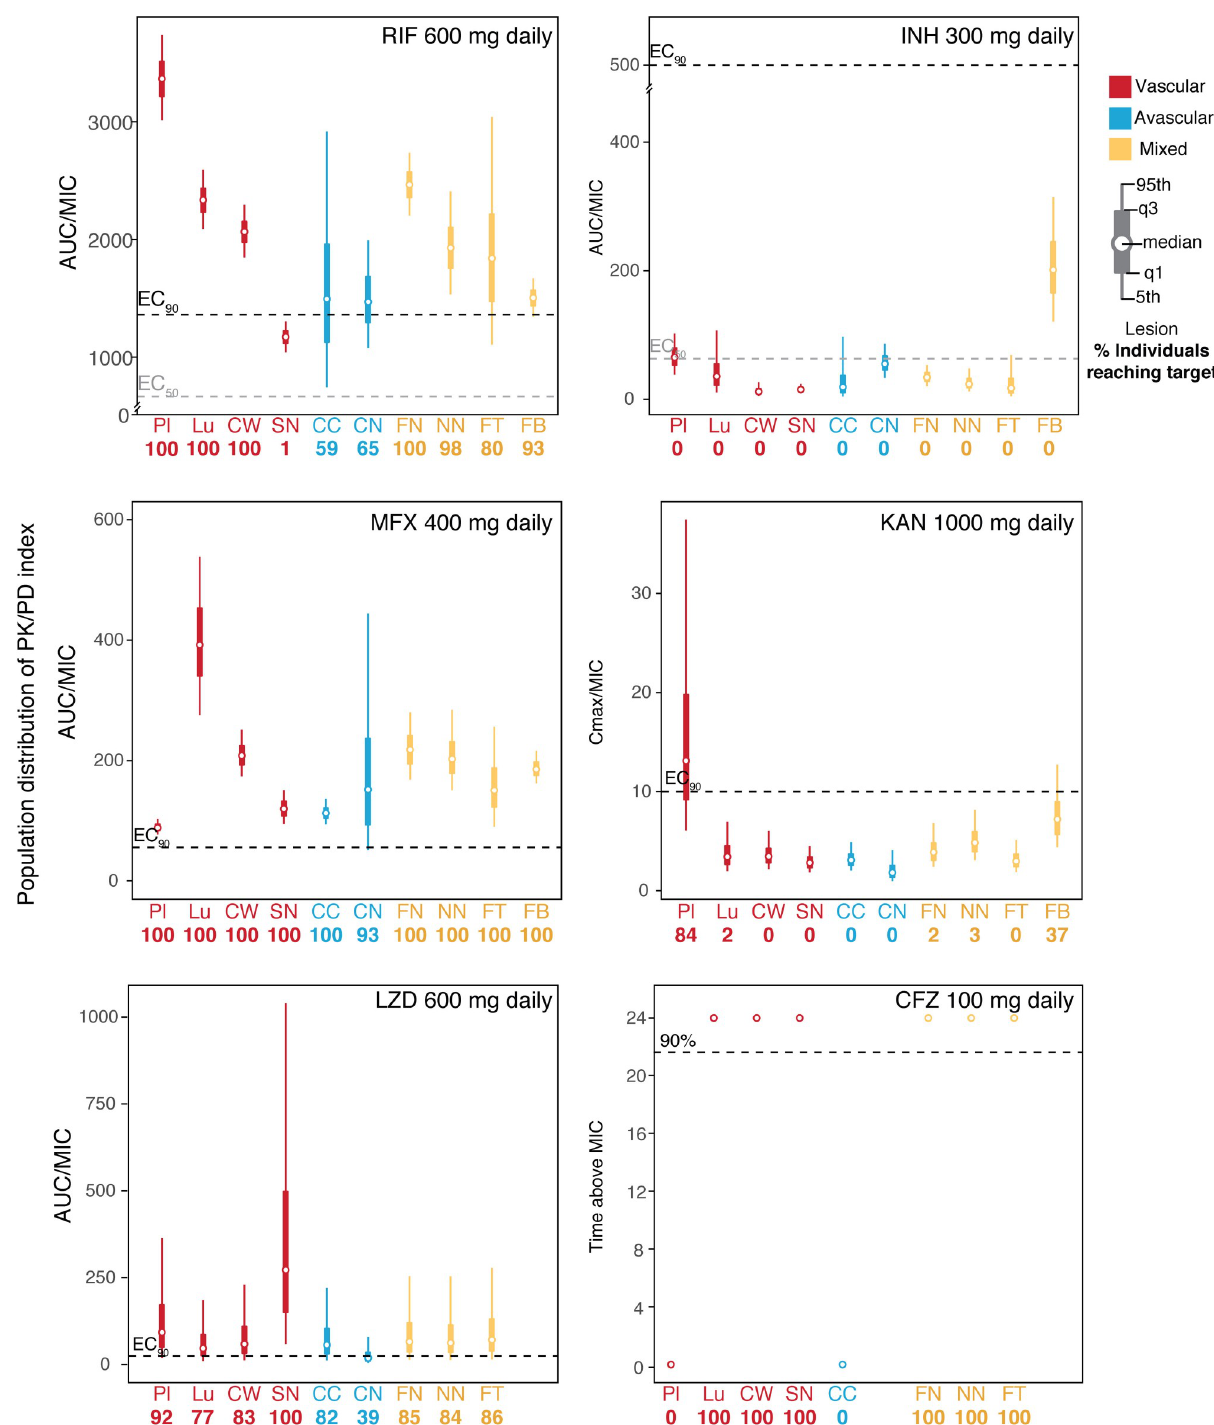
Fig 6. Distribution of PK/PD target attainment per drug. Exposure of 1,000 simulated patients are represented as box plots in each lesion to visualize the distributed PK/PD efficacy for individual drugs and lesions. Each panel represents an individual drug given at their standard dose until steady state is reached. The dashed lines indicate published target attainment PK/PD ratios, for which black dashed lines indicate the critical exposure values able to achieve � 90% of maximal kill (EC 90 ) values and gray dashed lines for drugs with published critical exposure values able to achieve � 50% maximal kill (EC 50 ). The percentage of the 1,000 simulated patients are printed below each box plot. Lesions are colored by their vascularity. CC, caseum from cavity; CN, closed nodule caseum; CW, cavity wall; EC 90 , 90% maximal effective concentrations; EC 50 , 50% maximal effective concentrations; FB, fungal ball;